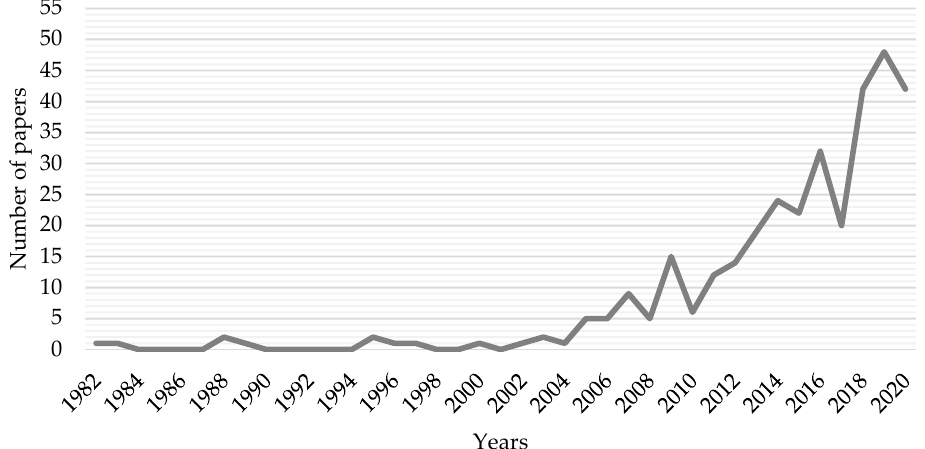
Figure 2. Evolution and quantification of the publications ( n = 334). Table 1. Journals with six or more papers on innovation in hotels from 1982 to 2020.